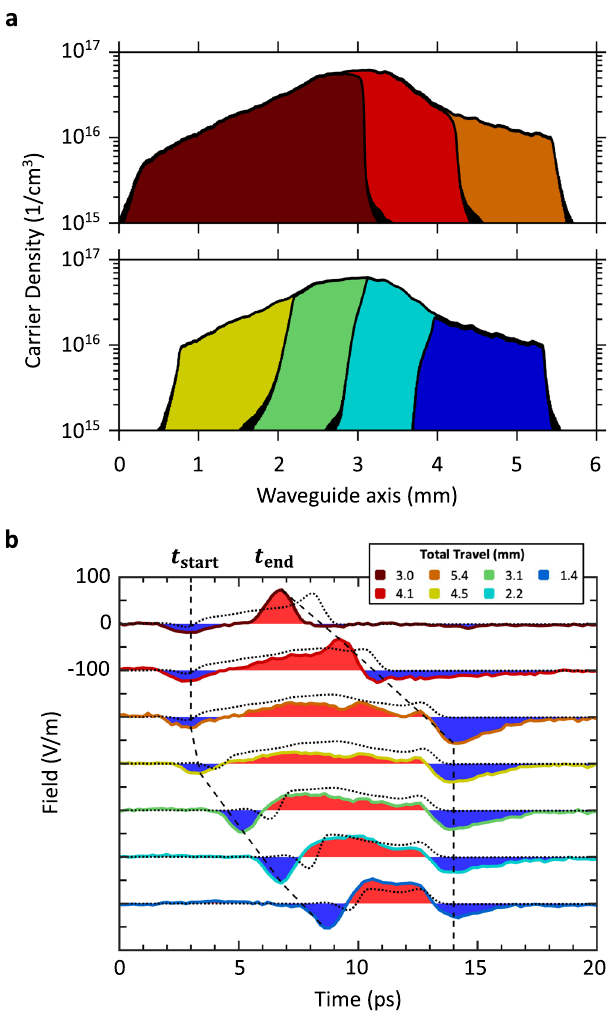
Fig. 2 Stretching the electric fi eld cycle using a sub-luminal moving front. a Carrier density pro fi les in the waveguide for different beam clippings of a sub-luminal front at v f = 0.86 c / n Si , varying either its termination (top) or start position (bottom), where the vacuum speed of light is c and the refractive index in silicon is n Si . b Measured (solid and fi lled) and simulated (dashed) electric fi elds of the THz plateau pulses. Each curve is color- matched to an input pump pro fi le from a , with red and blue fi ll indicating the positive and negative parts of the electric fi eld, Figure 3 demonstrates the concept of a front-induced transition, which is explained in more detail in ref. 5 . For